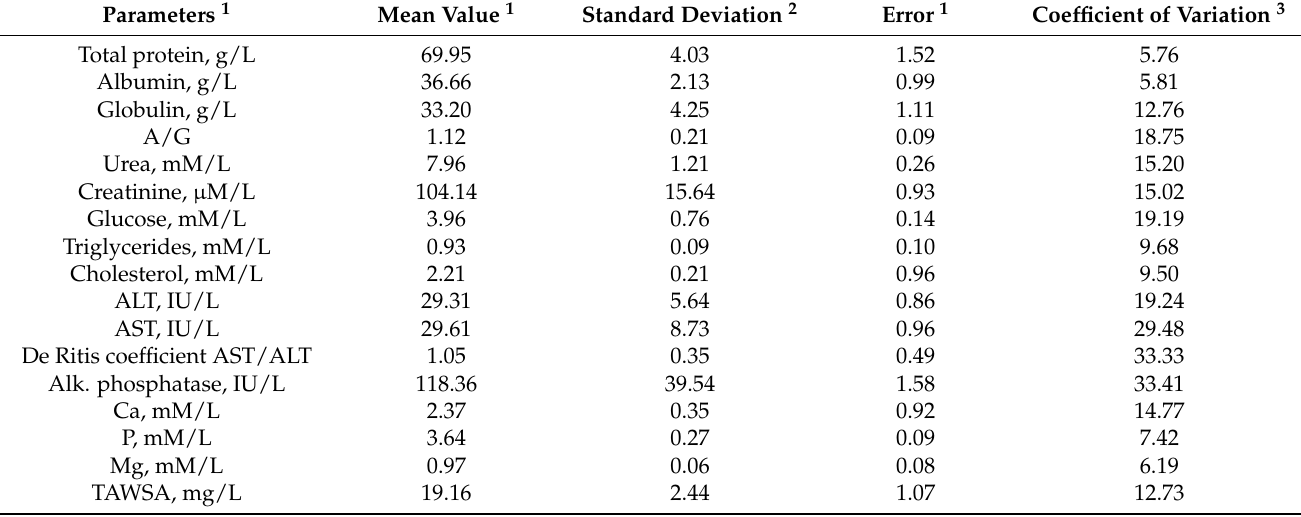
Table 3. Biochemical and antioxidant parameters of the blood serum of the Duroc breed pigs ( n = 12) in group 3 (100 days of